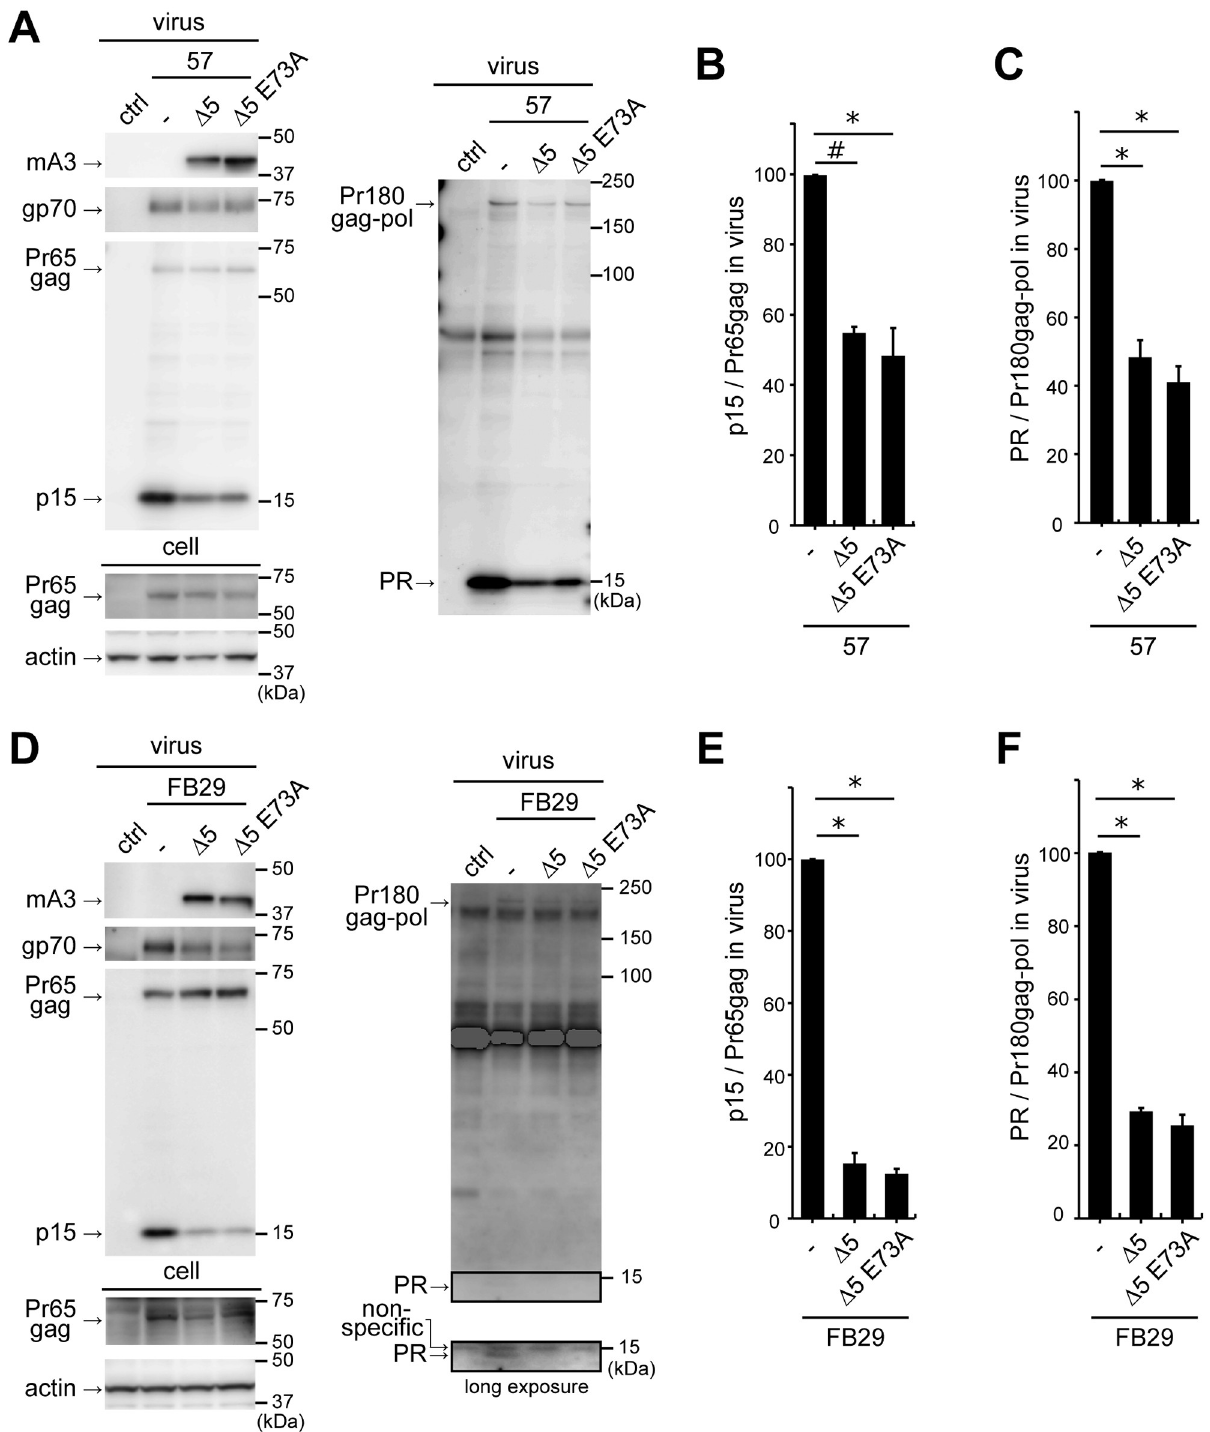
Fig 5. The impact of mA3 on viral protease-mediated processes was deaminase-independent. (A-C) The experiments were performed similarly to those shown in Fig 3A and 3C except by using the deaminase-inactivated E73A mutant ( Δ 5 E73A) along with the wild-type Δ 5 mA3. The data represent means with standard errors from three independent experiments. � , P < 0.001; #, P < 0.01 by one-way ANOVA with Tukey’s multiple comparison tests. (D-F) The experiments were performed similarly to those shown in Fig 3B and 3D except by using the E73A mutant along with the wild-type Δ 5 mA3. The image taken after a long exposure time for the detection of mature viral protease is also shown. � , P < 0.001 by one-way ANOVA with Tukey’s multiple comparison tests.